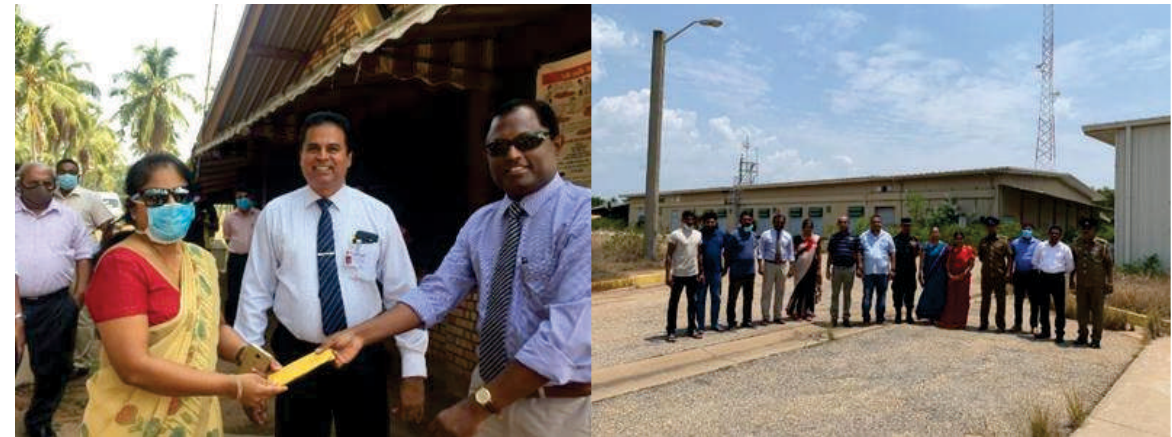
Figure 3: Keys to complex handed over to RDHS and inspection of complex by district